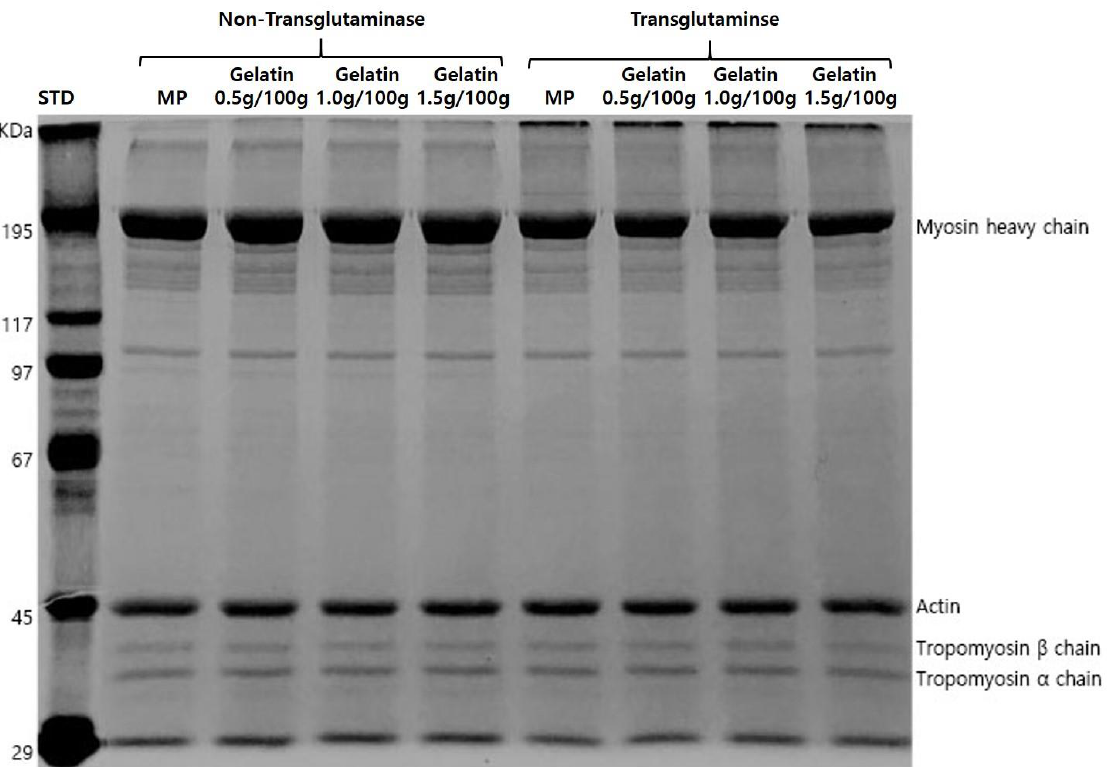
Figure 2. SDS-PAGE of myofibrillar protein mixtures with various additional levels of gelatin and transglutaminase.